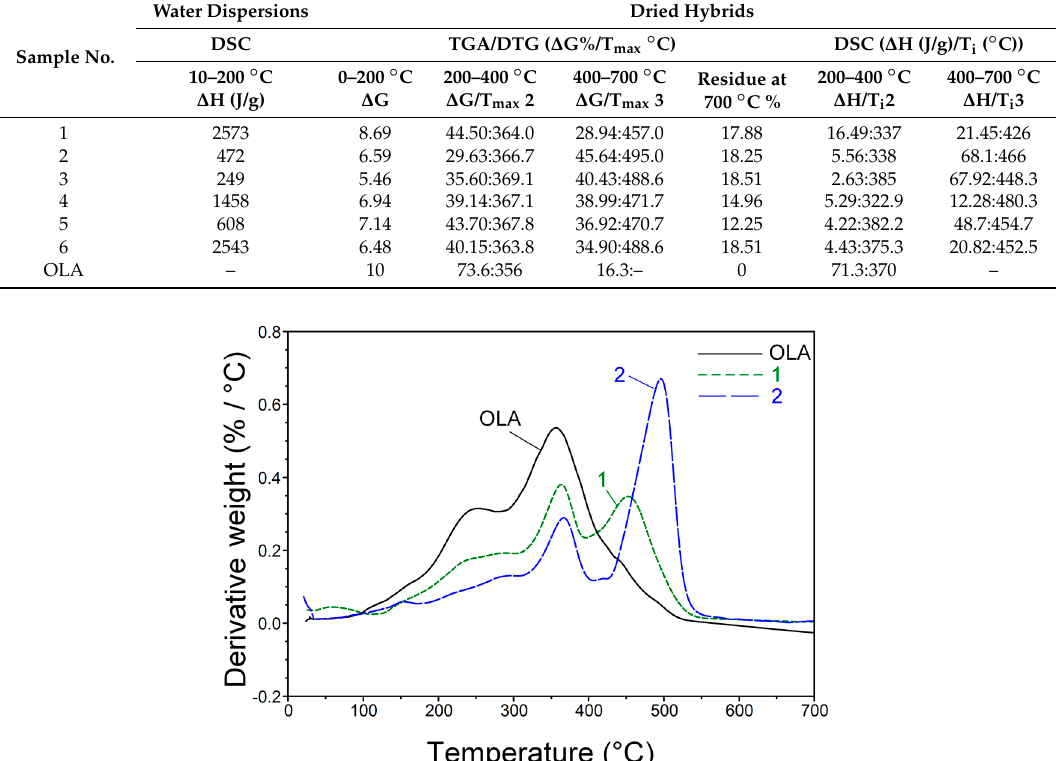
Figure 4. DTA diagrams for the pristine silica hybrid (Sample 1) and for ODTES-modified silica hybrid (Sample 2—ODTES/sodium silicate = 1 mol/1 mol).